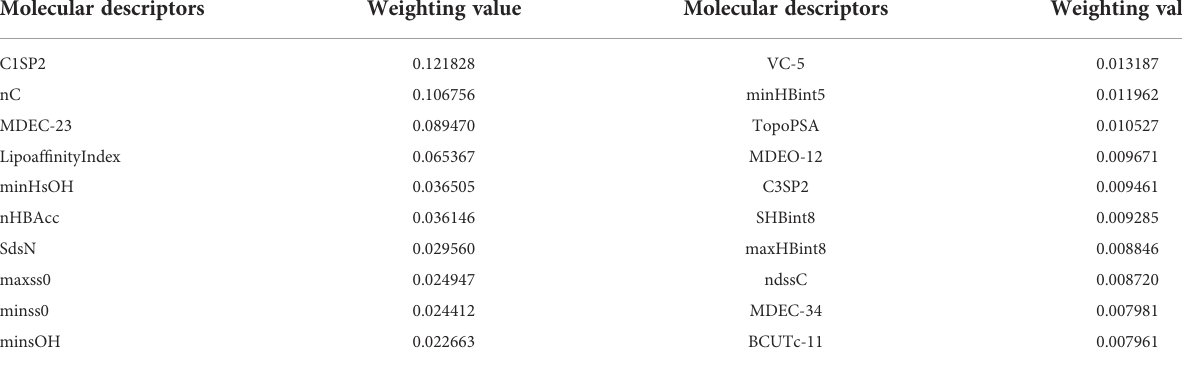
TABLE 1 Range of molecular descriptor values found by the optimization search